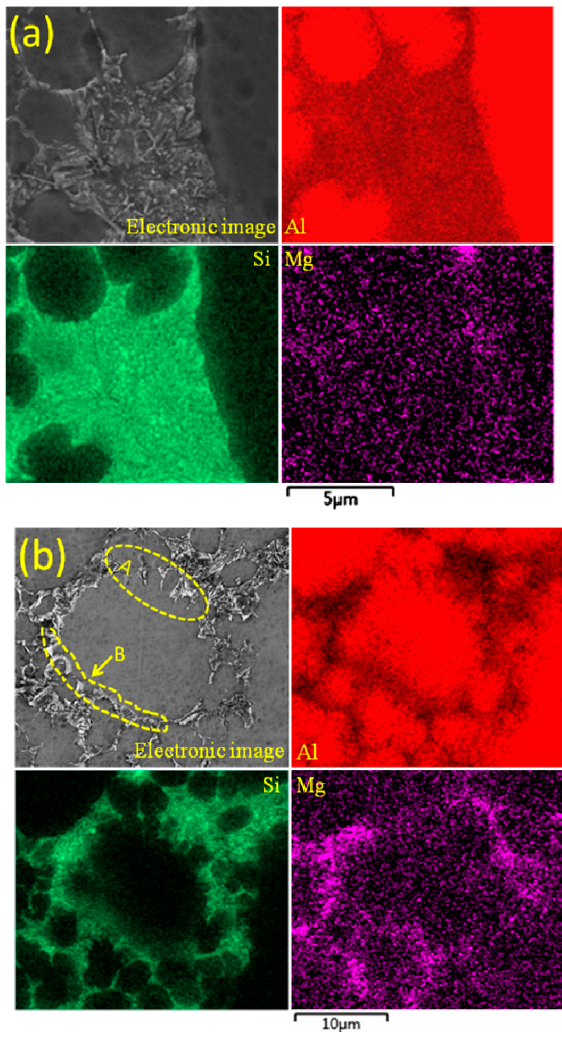
Figure 10. Element distribution diagram of alloy A356 by RDC ( a ) stable growth interface of α 1 particles, ( b ) instable growth interface of α 1 particles: A “cellular” structure and B “dentation” structure.